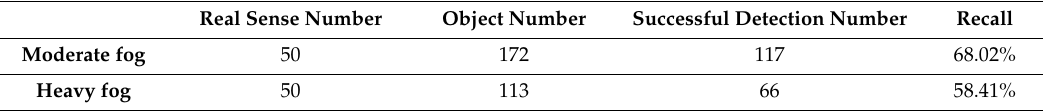
Figure 9. Display of the real scene detection results ( a ) in moderate fog, ( b ) in heavy fog. Table 4. Object detection recall in real fog